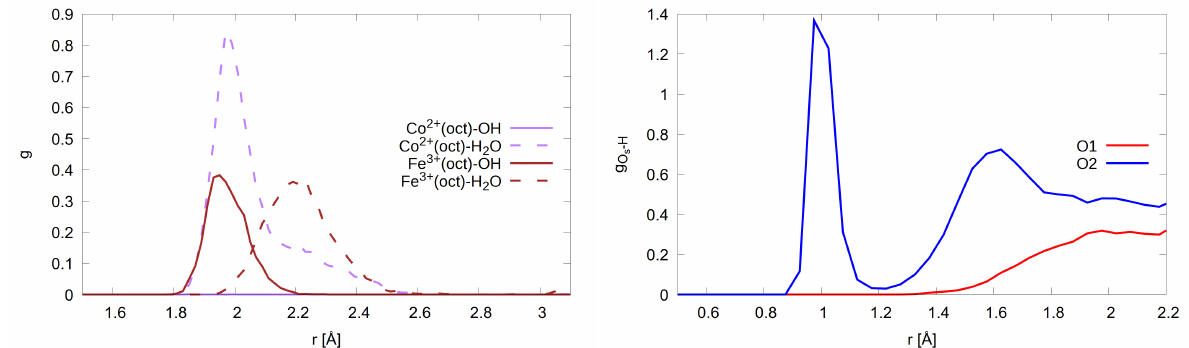
Figure 5. Radial distribution function of the adsorptions sites to the oxygen of water and hydroxide molecules ( left ) and the radial distribution function of the two lattice oxygen types (O1, O2) to hydrogen ( right ),